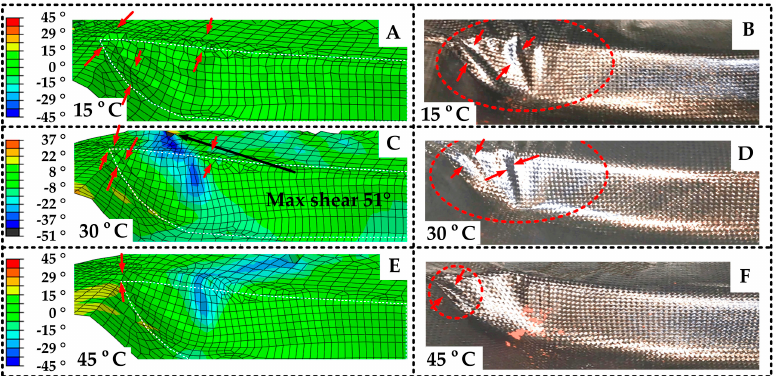
Figure 20. Wrinkles distribution comparisons: ( A ) the wrinkles of simulation at 15 °C; ( B ) the wrinkles of test at 15 °C ; ( C ) the wrinkles of simulation at 30 °C; ( D ) the wrinkles of test at 30 °C ; ( E ) the wrinkles of simulation at 45 °C; ( F ) the wrinkles of test at 45 °C.